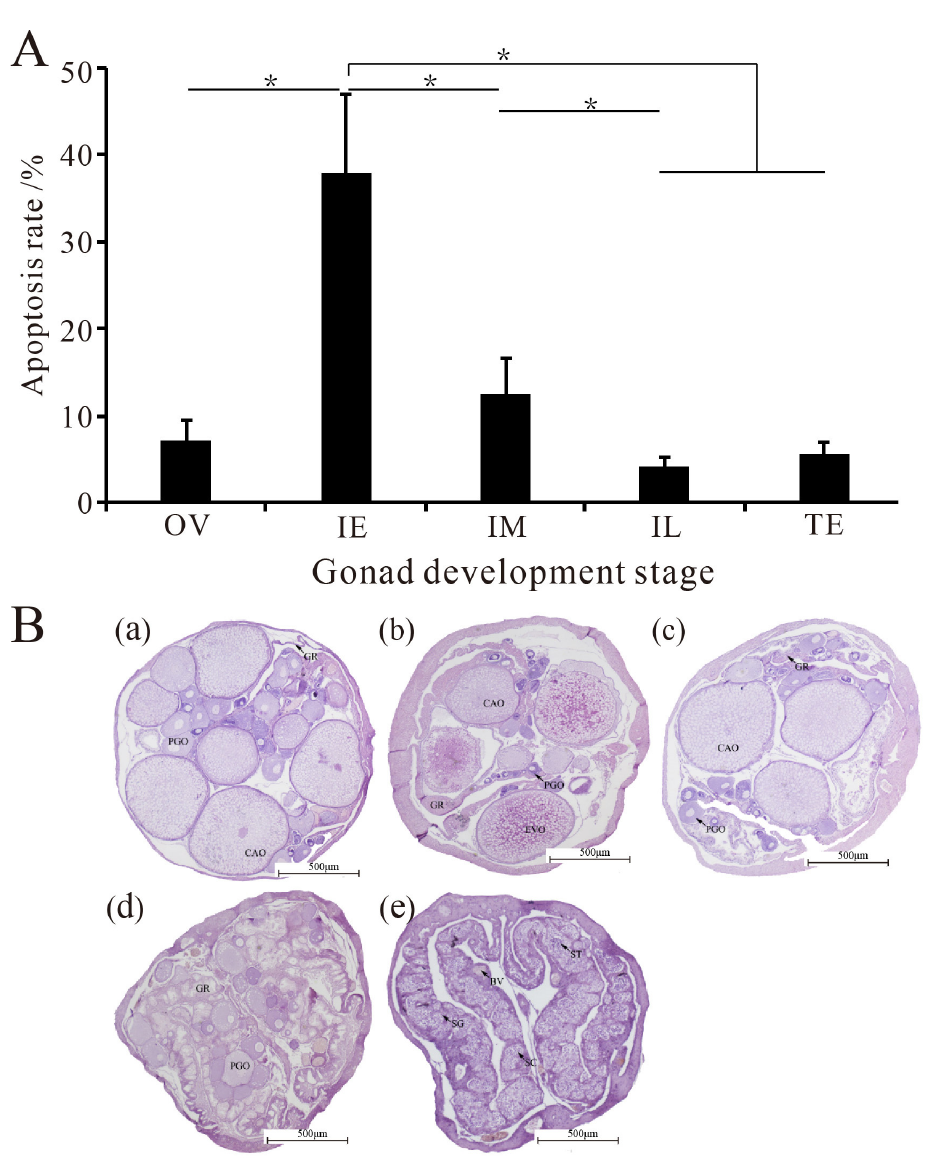
Figure 1. The apoptosis rates and histological changes in the gonad at different development stages of Monopterus albus . ( A ), Apoptosis rates in the five-development stage of gonad in Monopterus albus ; ( B ), Identification of the five development stages of gonad in Monopterus albus based on histological changes. ( a ), OV, ovary; ( b ), IE, early intersexual stage gonad; ( c ), IM, middle intersexual stage gonad; ( d ), IL, late intersexual stage gonad; ( e ), TE, testis stage. CAO, cortical alveoli stage oocytes; PGO, primary growth stage oocytes; YO, yolk oocytes; GR, gonad ridge; SC, spermatocyte. The results are presented as the means ± SEMs. Asterisks (*) indicate significant differences between two groups in Figure 1A ( p <